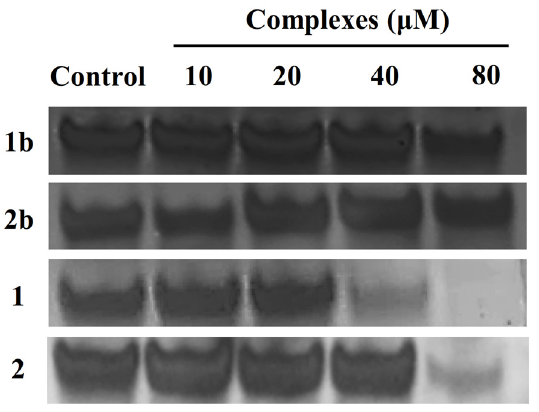
Figure 6. The replication blocking of PCR products obtained for different complexes concentrations.